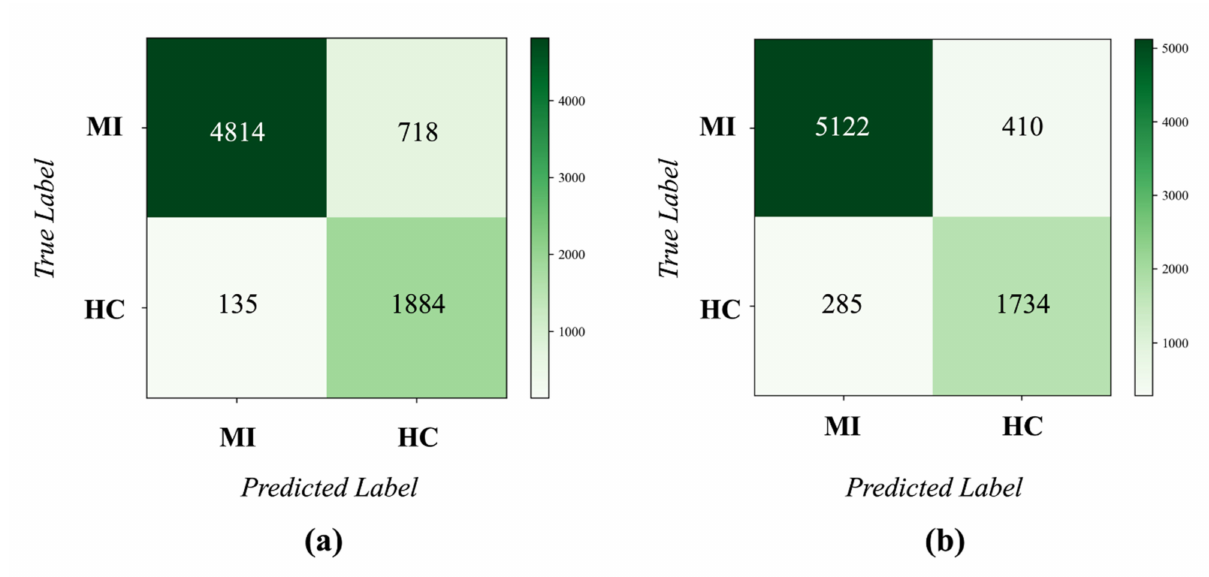
Figure 15. The confusion matrix of MI detection on the PTB-XL database. ( a ) MBN ( b ) EvoMBN.